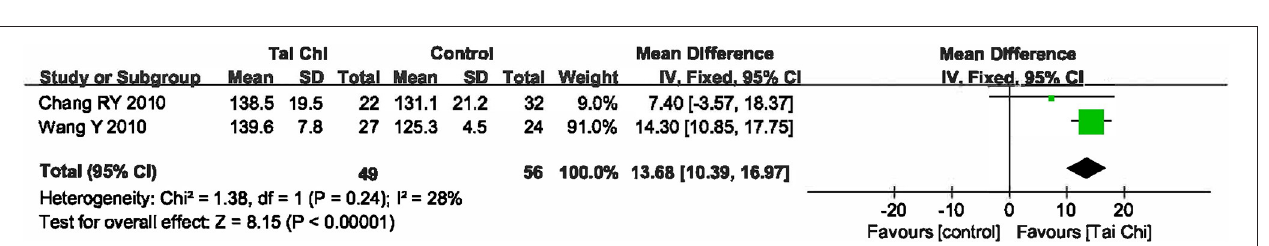
FIGURE 5 | Forest plot of the comparison between Tai Chi and blank for the outcome HR